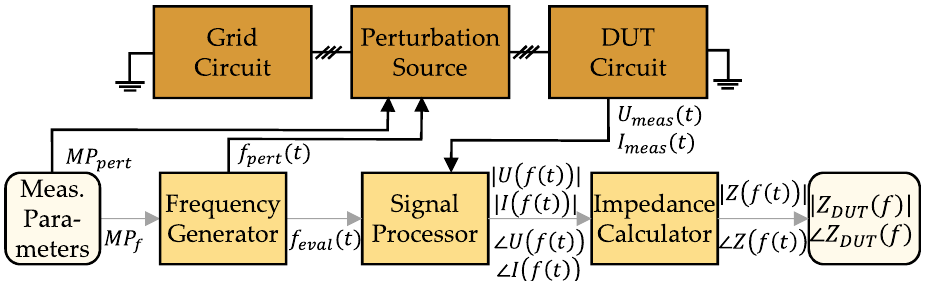
Figure 3. Impedance measuring method